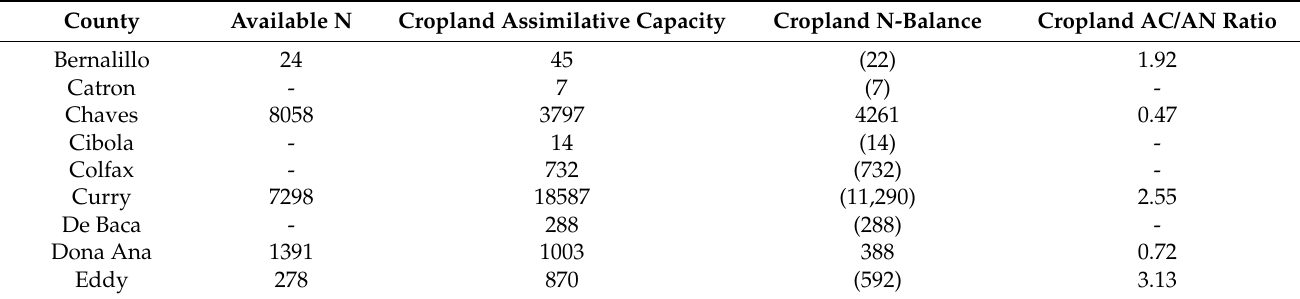
Table A2. County-level N-balance Assessment (in thousand